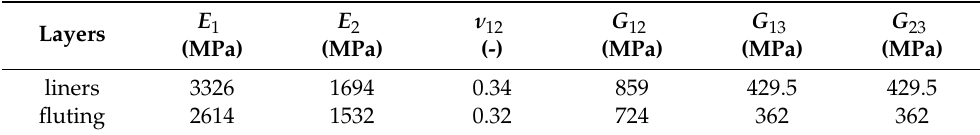
Table 1. Material data of intact double wall corrugated cardboard used for modeling the paper layers Figure 2. Material orientation. according to orthotropic constitutive relation.